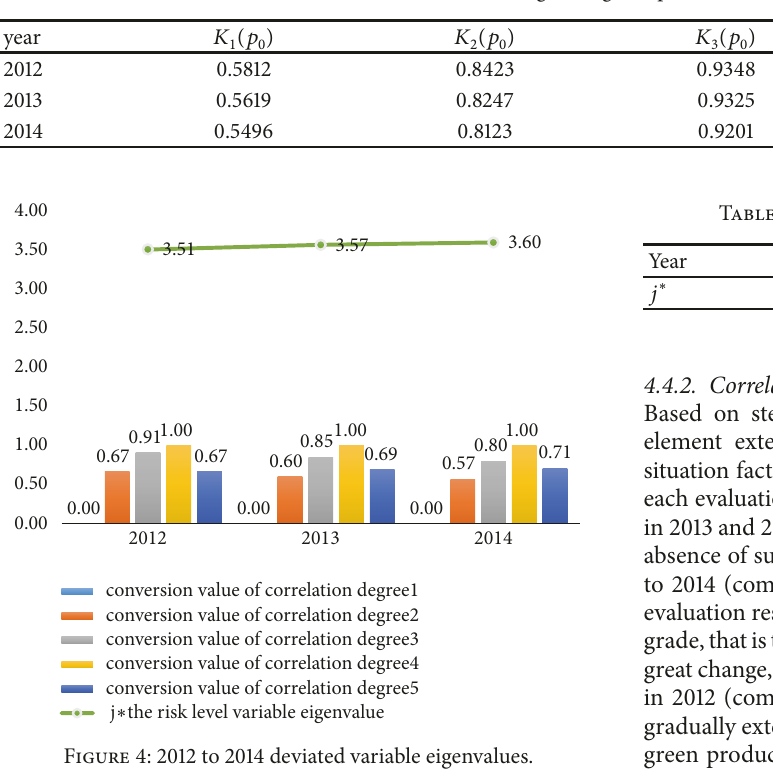
Table 4: Grade correlation degree of green production in thermal power plant.